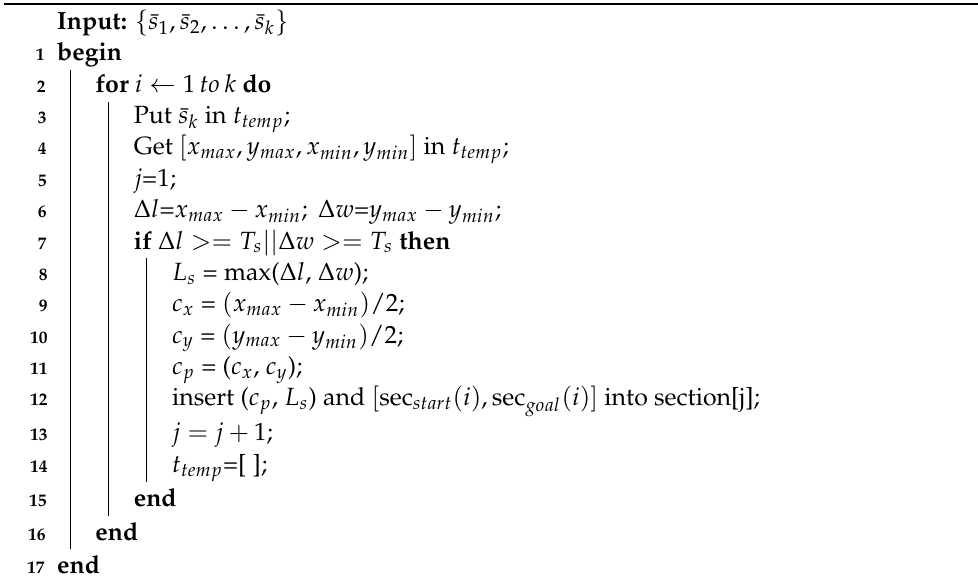
Algorithm 3: MAP SEGMENTATION AND COMPUTATION.